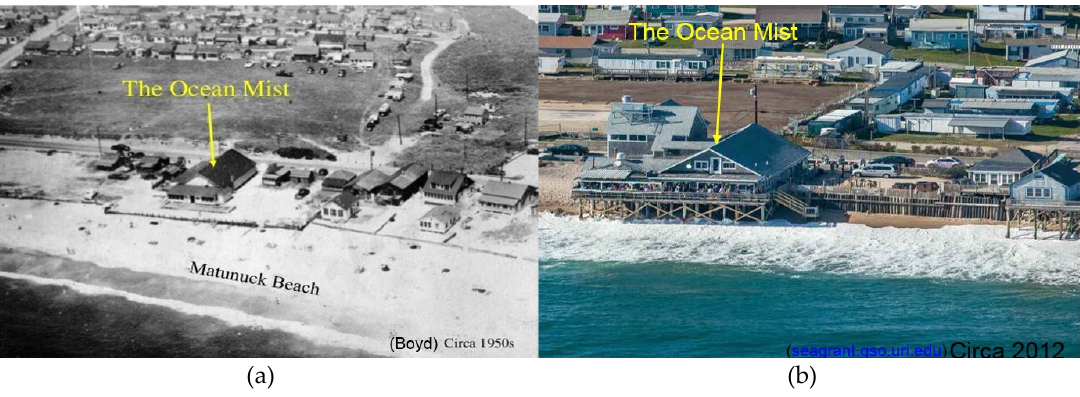
Figure 3. Photographs of a local restaurant in the study area from: ( a ) the 1950s; and ( b ) 2012, showing the loss of shoreline due to erosion [2].